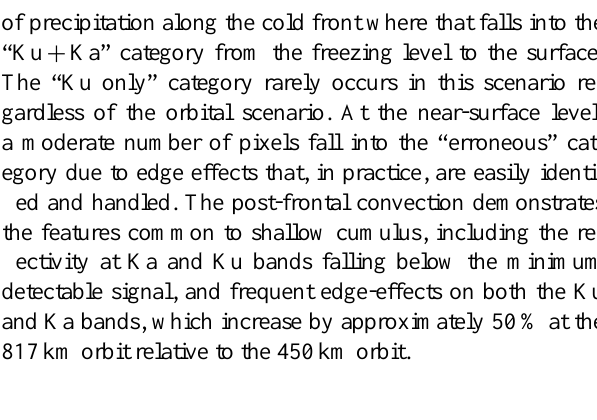
of precipitation along the cold front where that falls into the “Ku + Ka” category from the freezing level to the